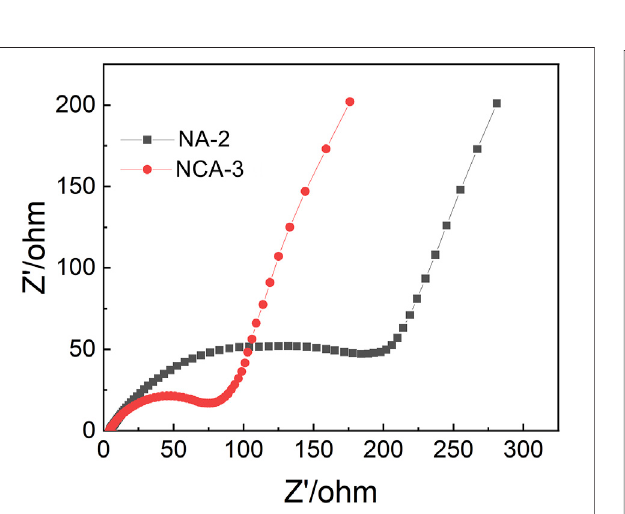
FIGURE 10 | Nyquist plots of the EIS data for the NA-2 and NCA-3 samples.